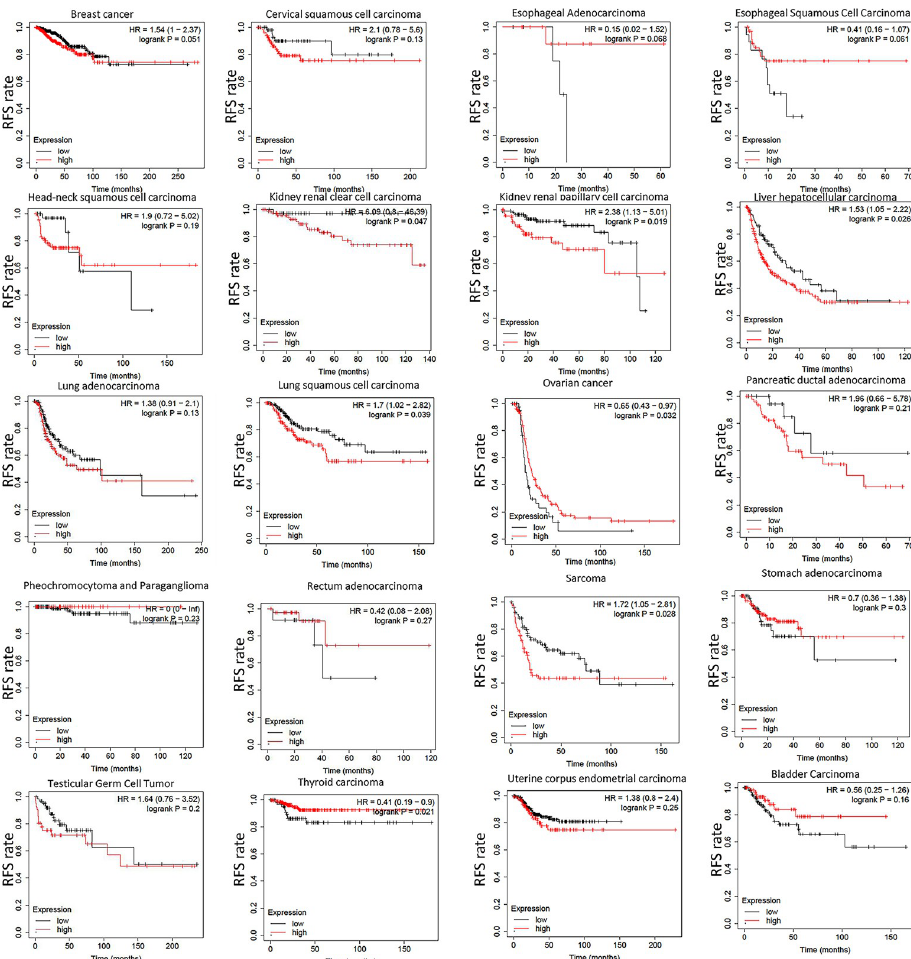
Fig 4. Kaplan-Meier analysis of the association of CALR expression with RFS in different cancers. Note: P value < 0.05 is considered statistically significant. RFS, relapse-free survival.